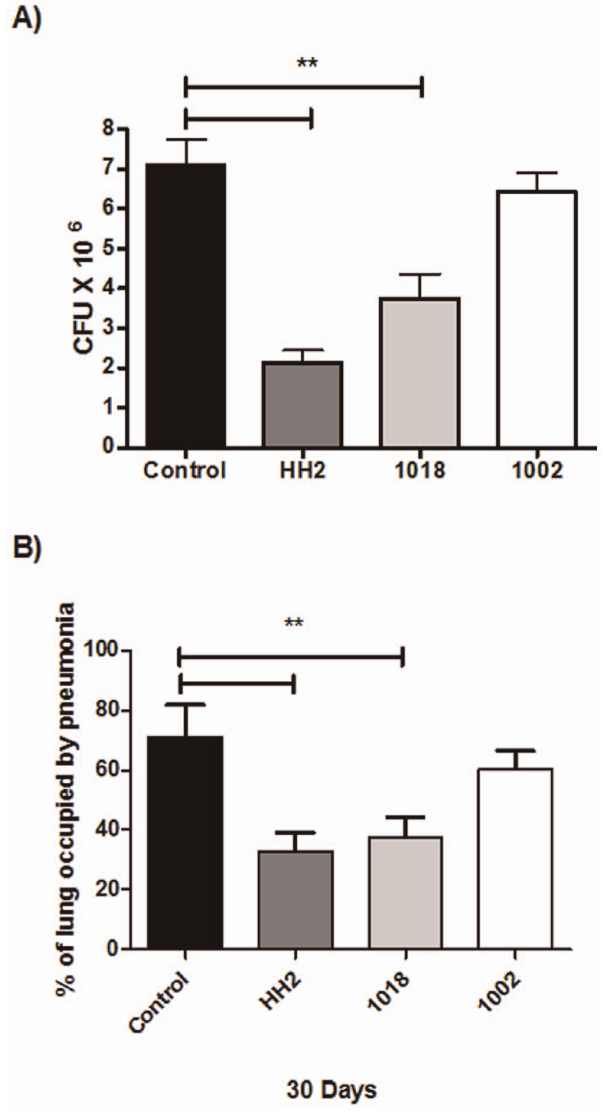
Figure 6. Effect of antimicrobial peptides on the treatment of mice infected with a drug-resistant strain. (A) Animals were infected with the MDR strain and after 60 days treated three times per week with 32 m g in 100 m L of saline solution of the indicated peptide. Compared to the control untreated animals, IDR peptides HH2 and 1018 induced a significant decrease in lung bacillary loads. (B) Measurement of the area of consolidation of pneumonia showed that only HH2 and 1018 significantly reduced the pneumonic areas when compared with control mice. The data is expressed as means 6 standard deviation of 3 independent experiments; p , 0.01 indicated with a bar and **over the two bars was considered statistically